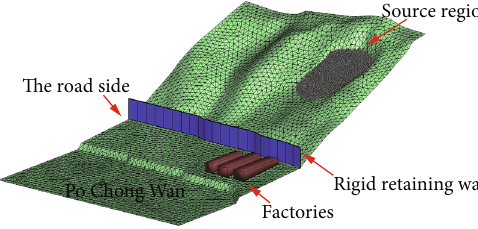
Figure 5: Rigid retaining wall along the